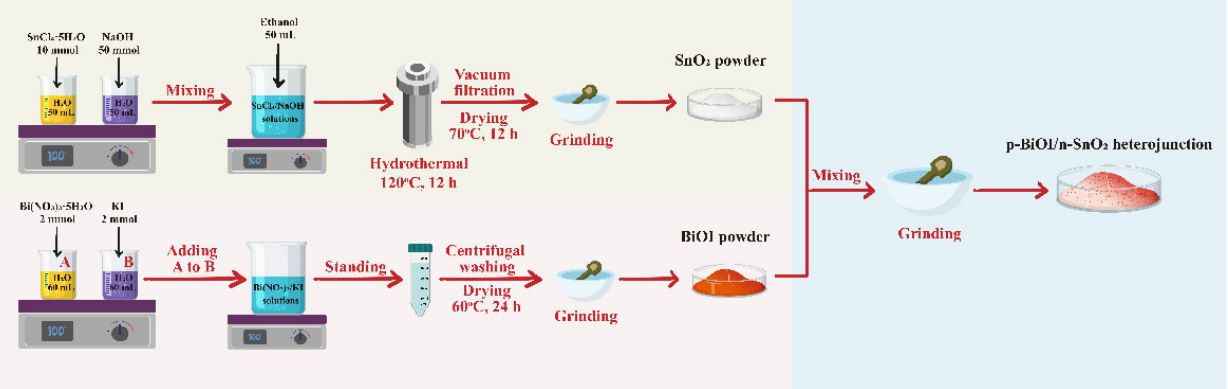
Figure 1. Fabrication procedure of p-BiOI/n-SnO 2 heterojunction.